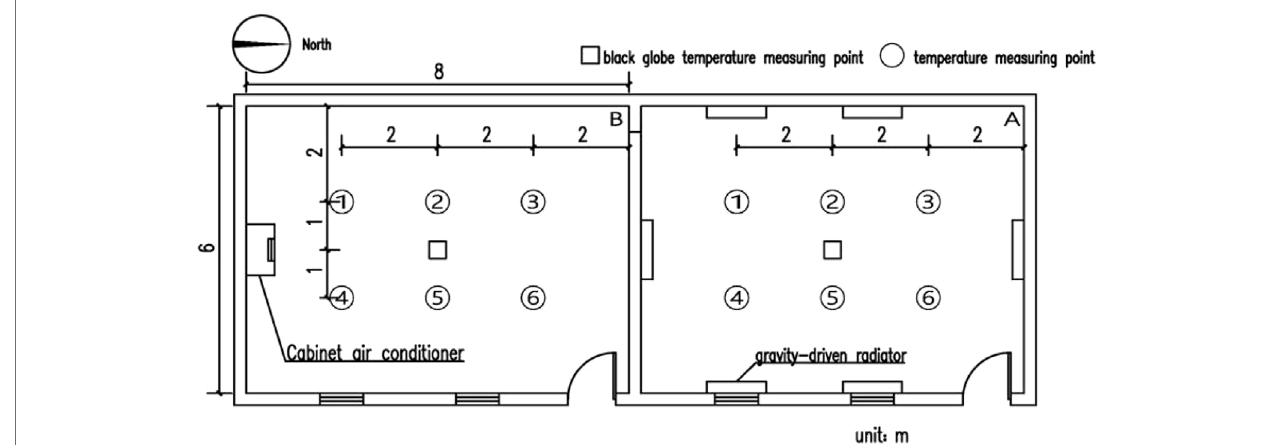
FIGURE 2 | Horizontal arrangement position of the experimental measuring points.